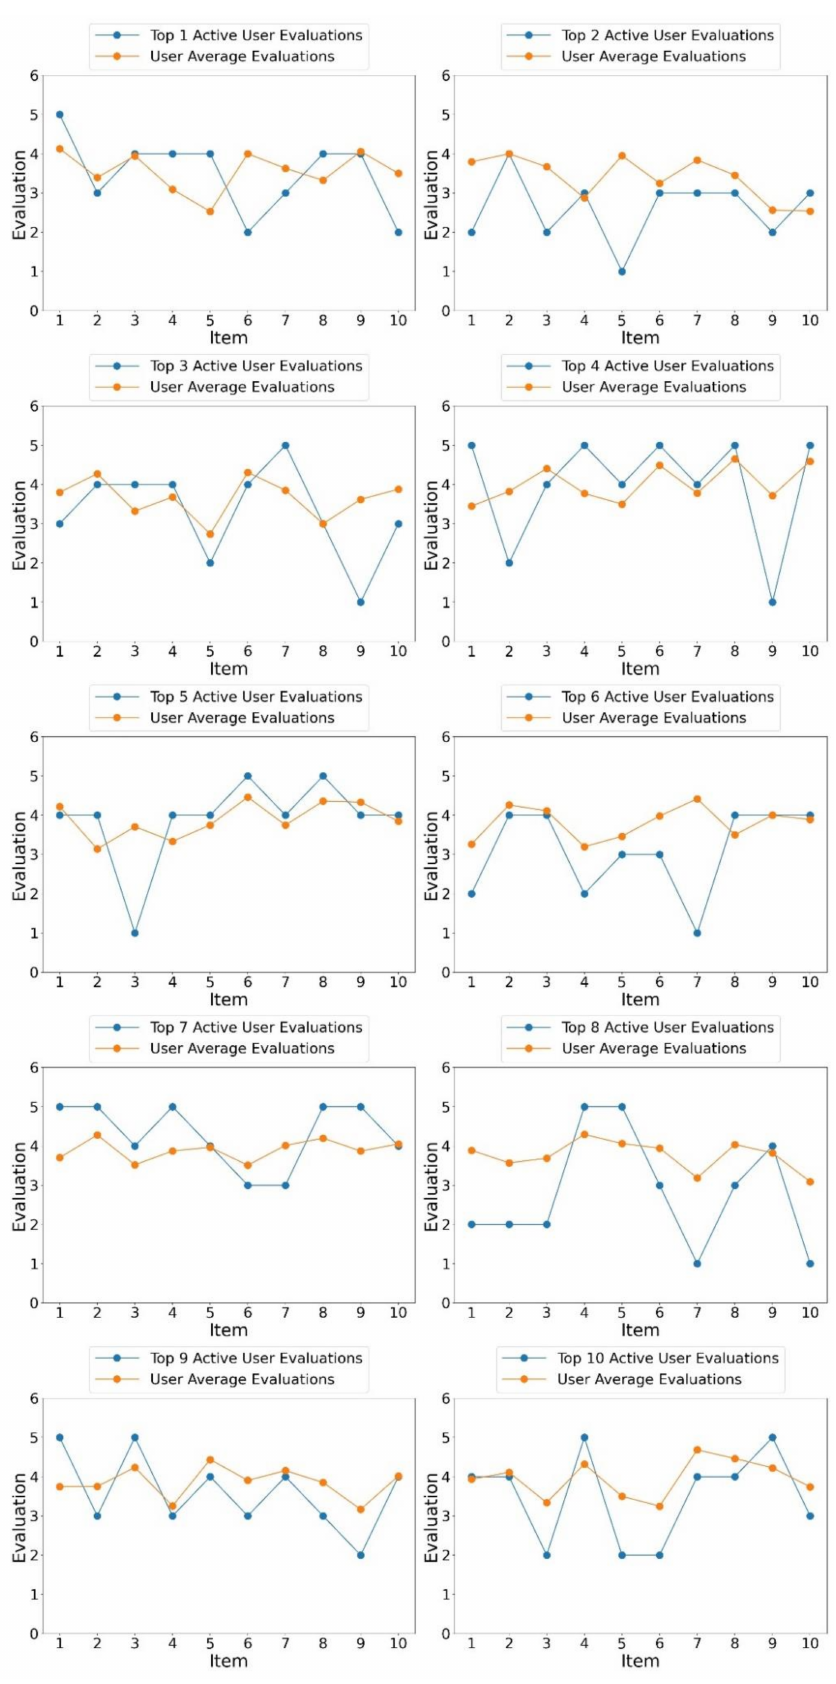
Figure 5. Comparison of the evaluations by the top 10 active users to the average evaluations by all